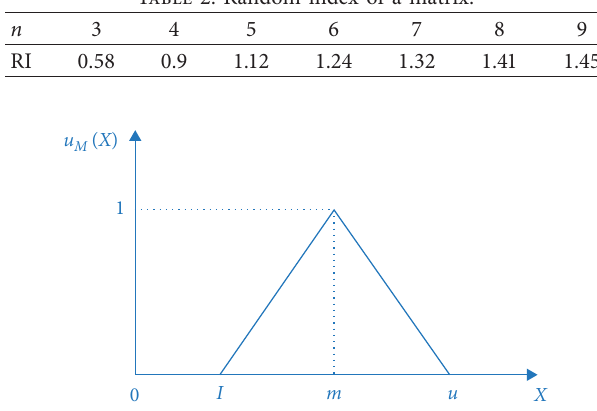
Figure 3: Triangular fuzzy number (TEN)